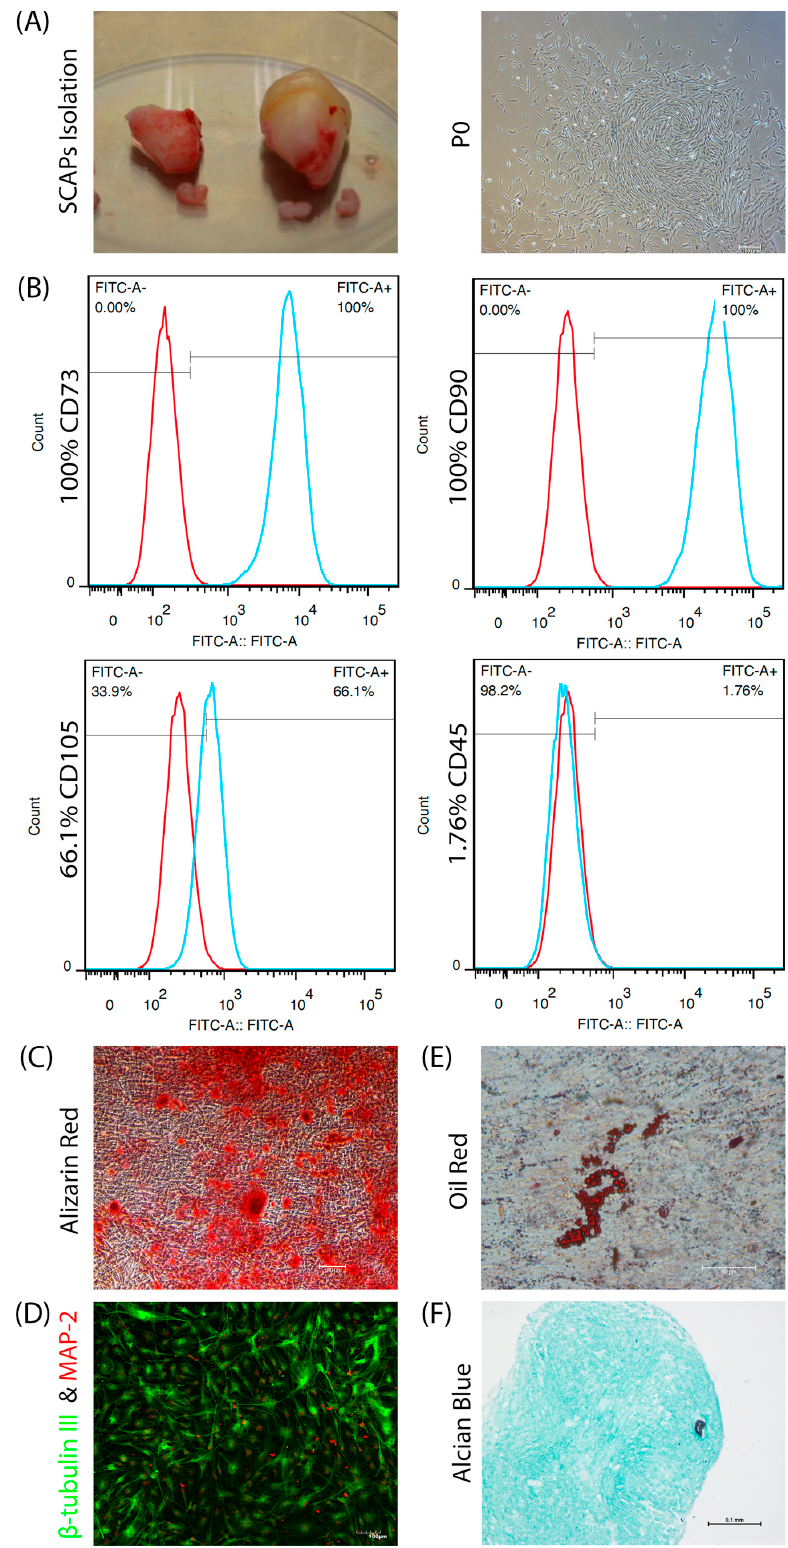
Figure 1. ( A ) Microscopic images for SCAPs isolation; ( B ) Flow cytometric results for SCAPs characterization; Microscopic images for ( C ) osteogenic, ( D ) neurogenic, ( E ) adipogenic, and ( F ) chondrogenic multi-differentiation assay.